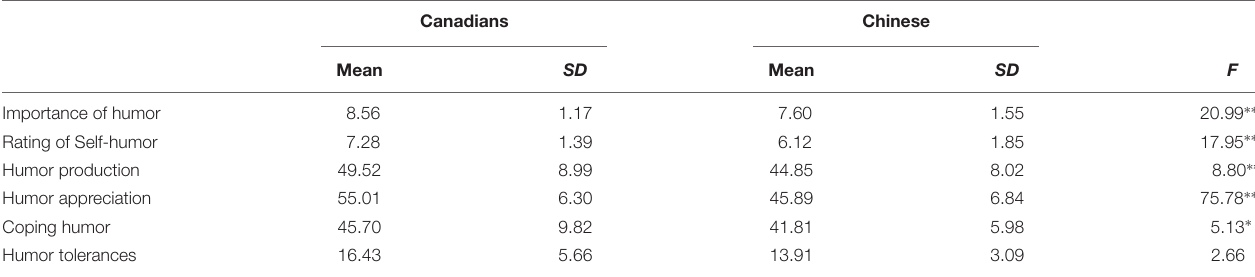
TABLE 1 | Cultural differences on perception of